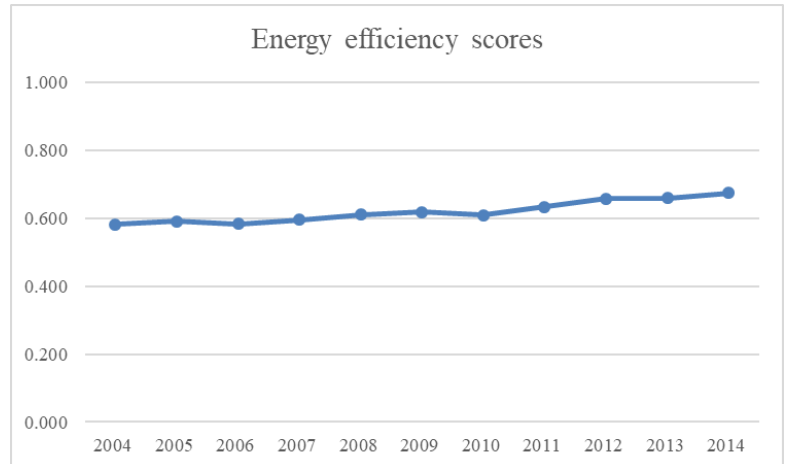
Figure 2. Average efficiency scores for the Baltic states 2004 – 2014.